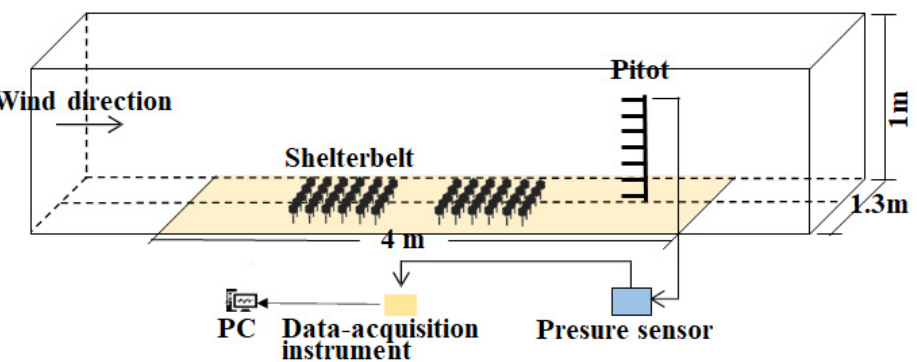
Figure 1. Schematic diagram of the experimental wind tunnel.